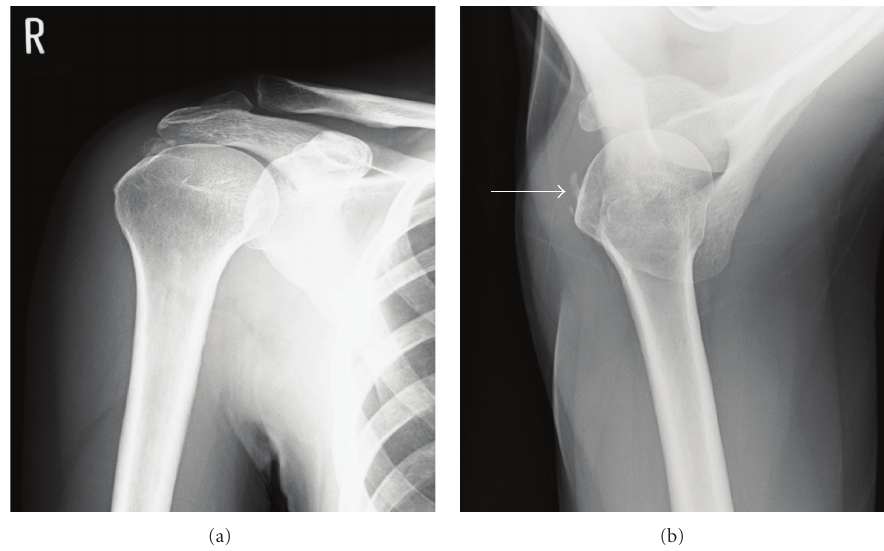
Figure 1: (a) and (b) Preoperative radiographs (anteroposterior view, axillary view) showing calcific deposits in the upper and anterior portion of the humerus. White arrow indicates the presence of calcific deposit at the lesser tuberosity.